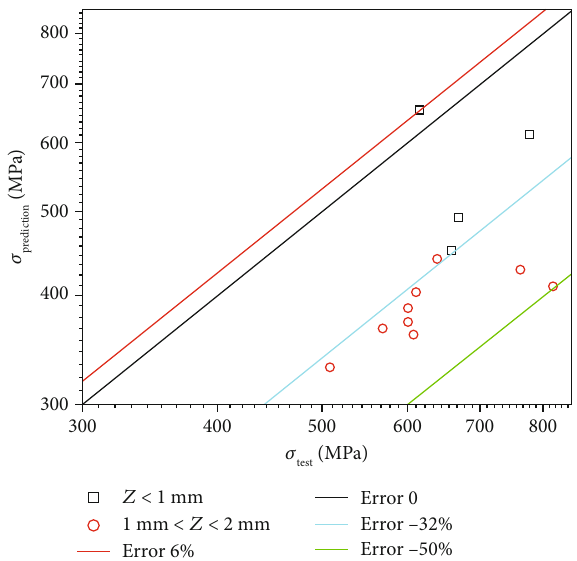
Figure 15: Prediction error distribution of the WCN model.